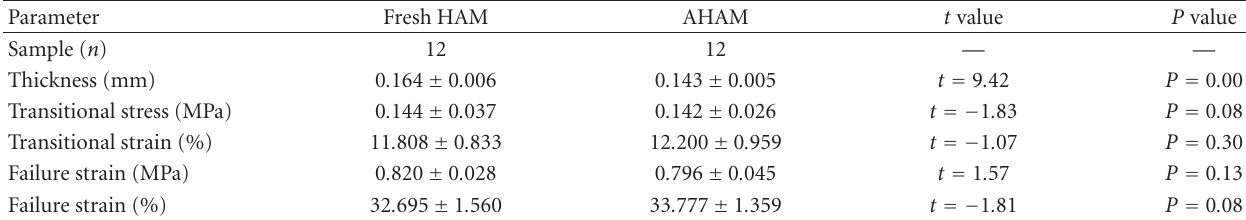
Figure 3: Morphology of HFFs and quantification of cell length, width, and spread area on the indicated substrates. ((a) and (b)) β -actin was detected by immunofluorescence staining to visualize the cytoskeleton and morphology at 24h after plating cells on glass coverslips (a) or the AHAM (b). Scale bar, 50 μ m. ((c) and (d)) The cell spread area (c) and axial ratio (d) were calculated on the indicated substrates after immunofluorescence staining. Cells on coverslips were nearly twice as large in terms of their cell spread area, compared with that of cells cultured on the AHAM. Error bars indicate standard error ( ∗ P < 0 . 05 and ∗∗ P < 0 . 001). Table 1: Biomechanical properties of the fresh amnion and the